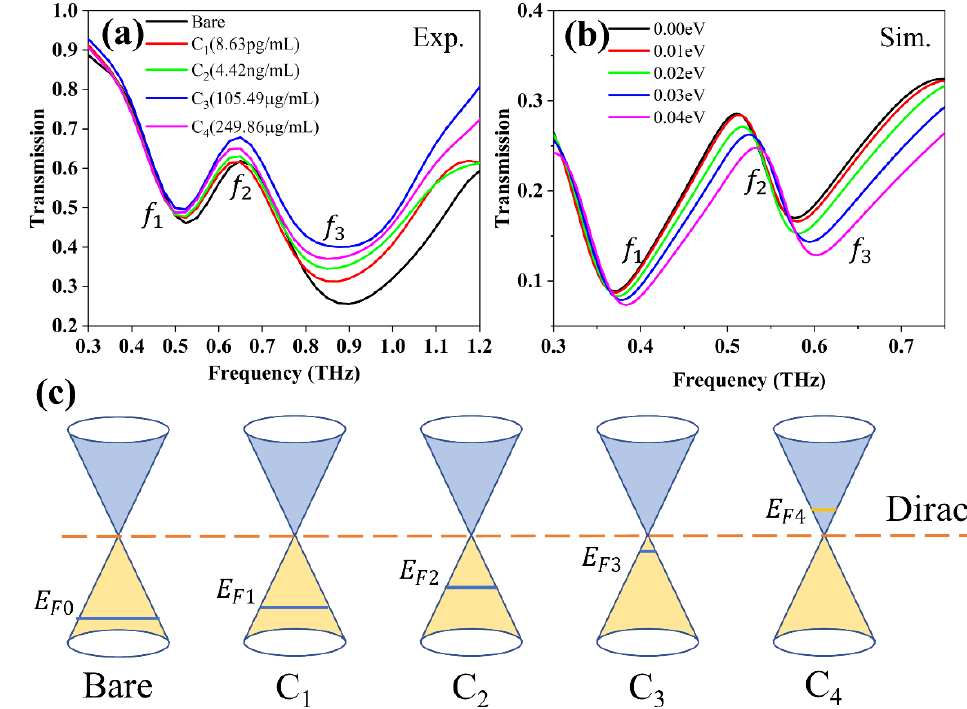
Figure 4. ( a ) Transmittance spectra of sensors with different concentrations of OVA. ( b ) Simulated spectra of different Fermi levels of graphene for the sensor. ( c ) Schematic of graphene Fermi level changes under the influence of various concentrations of OVA.